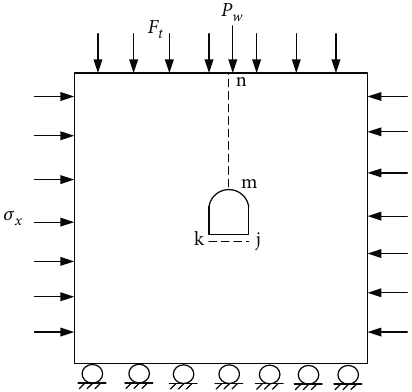
Figure 9: The numerical simulation model of surrounding rock of karst tunnel.